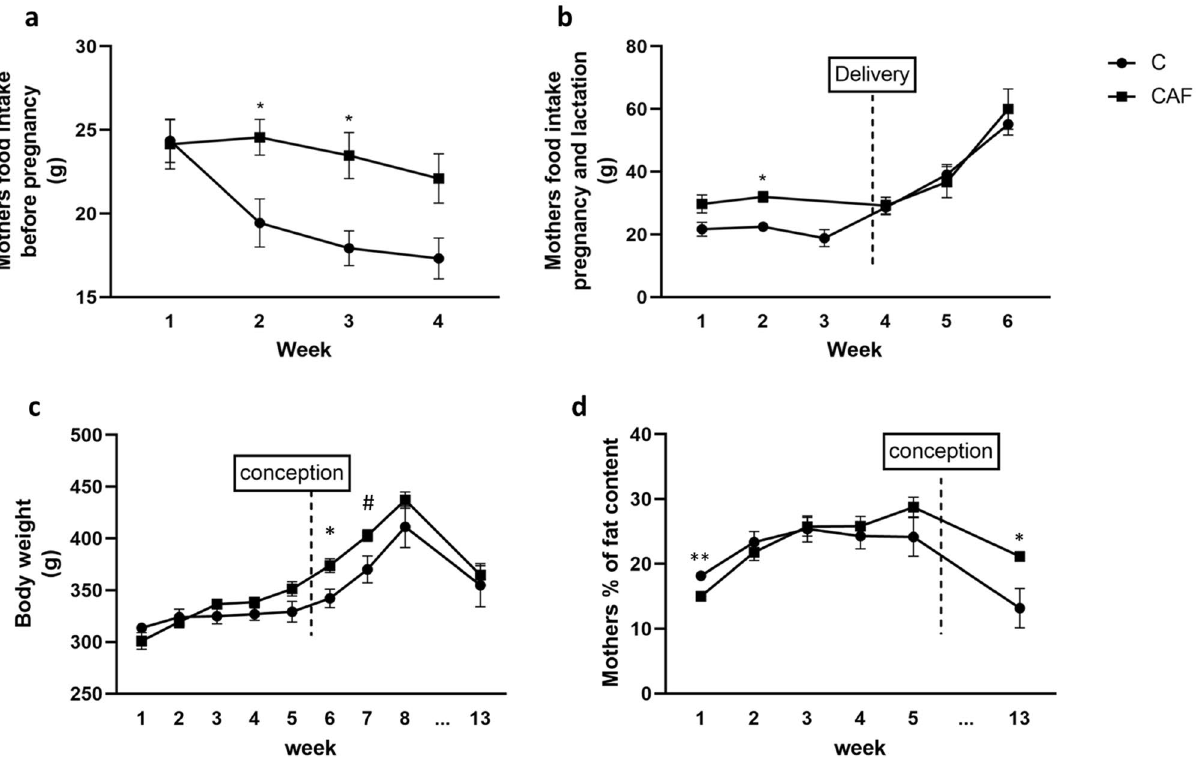
Figure 1. Mothers food intake before pregnancy and during pregnancy and lactation, and maternal body weight and fat content. ( a ) Weekly average of food intake in CAF and C groups before pregnancy; at 2 and 3 weeks CAF mothers had a significantly higher food intake (p’s < 0.05); ( b ) weekly average of food intake during pregnancy and lactation. At the 2nd week CAF mothers had significantly higher food intake (p < 0.05); ( c ) mothers weight in weekly time points: before pregnancy, during pregnancy, and at the end of the experiment; ( d ) percentage of fat content in mothers measured weekly before pregnancy and at the end of the experiment; black square—CAF females, black dot—C females (*p < 0.05; **p < 0.01; # p = 0.06); n = 3 mothers/group .